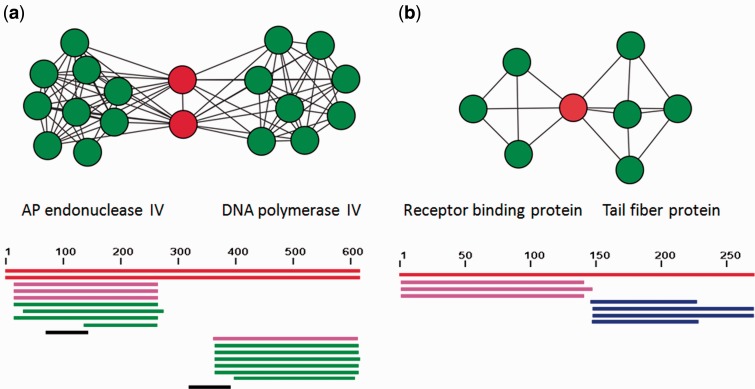
Examples of subgraphs with detected composite genes. Top panel: Subgraphs showing all direct neighbors of composite genes. Nodes (red for composites, green for components) correspond to genes connected by edges when they share a BLAST E value <10−5. Bottom panel: BLAST alignment showing the overlap between the sequence of a composite for the above gene families and component sequences. A plain segment indicates a region with overlap (significant similarity according to BLAST). Segments are colored to reflect bitscores (black: <40, blue: 40–50, green: 50–80, pink: 80–200, red: >200). Segments in different lines come from different genes. Top red segments correspond to composite genes, other segments to component genes. (a) AP endonuclease IV/DNA polymerase IV fusions in Melanoplus sanguinipes entomopoxvirus and Amsacta moorei entomopoxvirus. Component genes belong to NCLDV. (b) Composite receptor-binding protein in Lactococcus bacteriophage bIBB29. Sequences in the left component come from Lactococcus phages sk1, jj50, and 712; sequences in the right component come from Streptococcus pyogenes phage 315.5, Cronobacter phage vB_CsaP_GAP52, Lactococcus phage 949, and Vibrio phage KVP40.